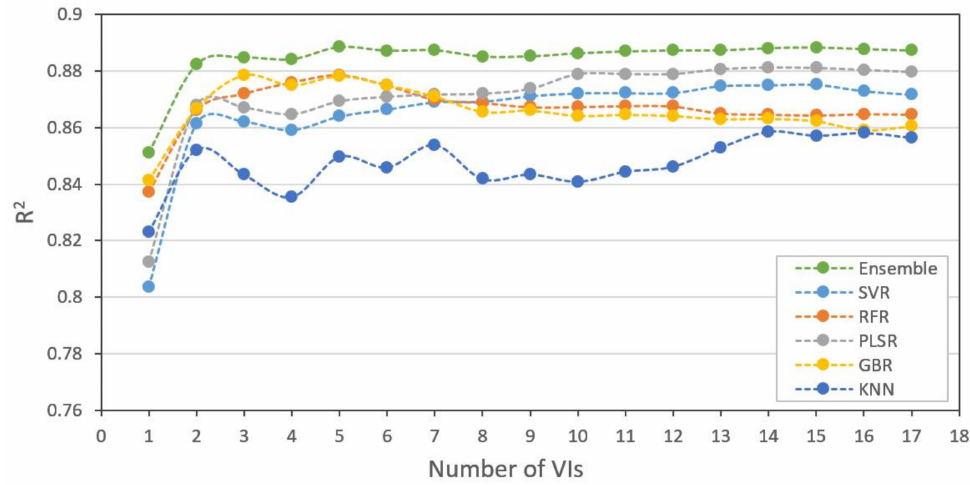
Figure 11. Model training accuracies as a function of the number of VIs derived from 0.007 m GSD multispectral data.